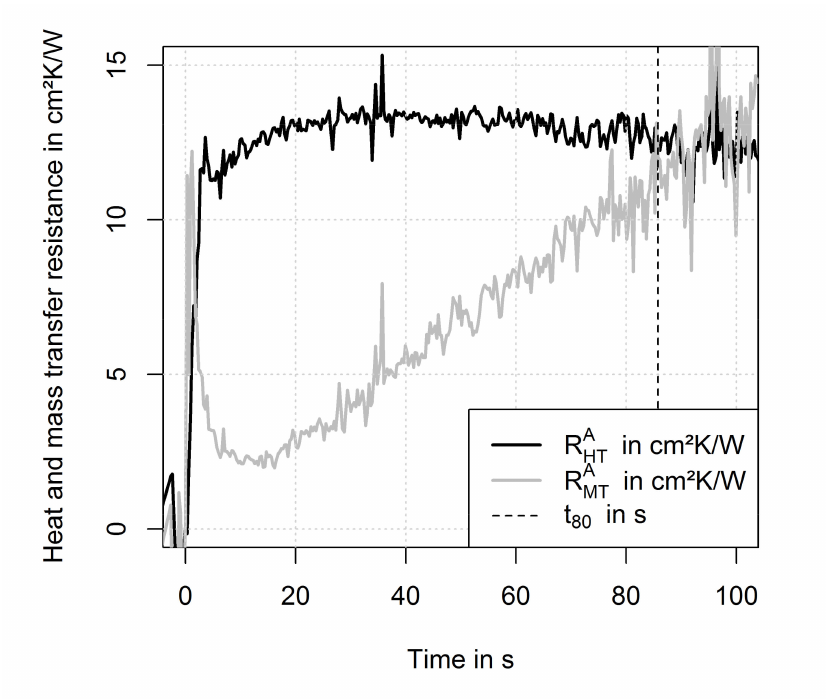
Figure 10. Area-scaled heat and mass transfer resistance R A curves of sample we55 desorption measurement, the end time t 80 for the evaluation of mean values R